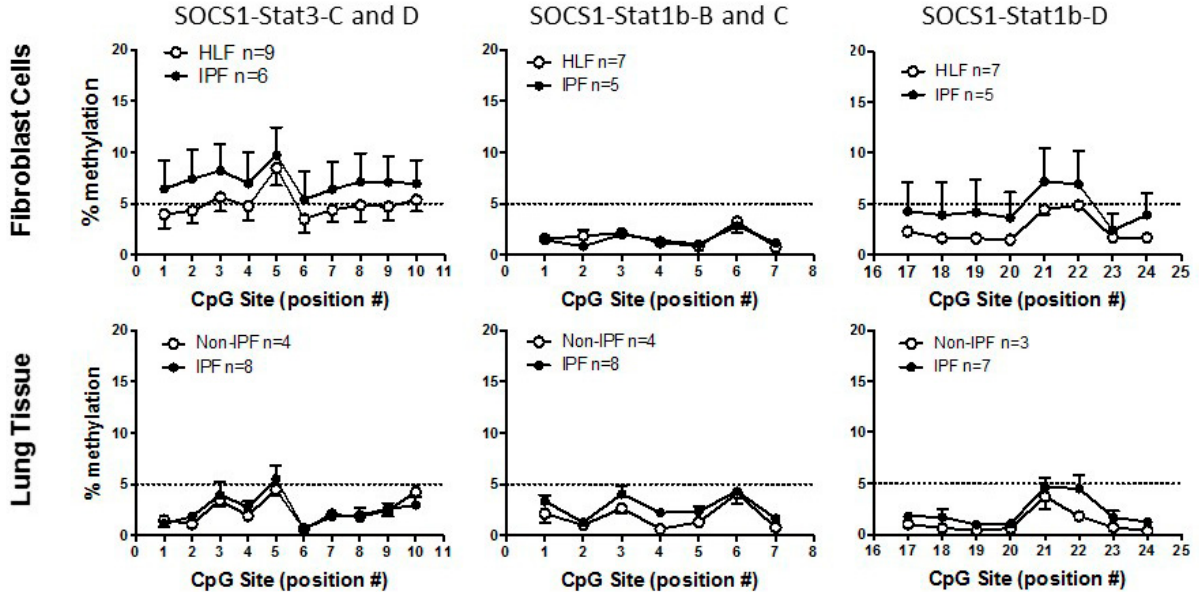
Figure 2. Approximately 500 bp of sequence surrounding the stat1 and stat3 transcription factor binding sites (TFBS) in the promoter region of SOCS1 were input into the software. CpG sites within or adjacent to the predicted TFBS were selected as target sites for analysis and primers designed to target these sites were chosen from a list generated by the software on the basis of the algorithms predicted assay quality. PCR sequencing primers for each assay are listed in Table 1. DNA samples were converted using the Epitect Bisulphite Conversion Kit (Qiagen). All PCR amplifications were performed with the PyroMark PCR Kit (Qiagen) and products visualized on a 2% agarose gel to confirm quality. The amplicons containing the CpG target sites were PCR amplified using a biotin labeled, HPLC purified forward primer and standard sequencing grade reverse primer. The PCR product was bound to streptavidin sepharose high performance beads (GE Healthcare Life Sciences), following a washing and denaturation step the beads were transferred to optically clear, 24 well sequencing plate in the presence of the pyrosequencing primer. Pyrosequencing was performed on a PyroMark 24 Pyrosequencing System (Qiagen) as per the manufacturer’s instructions. Data were analyzed on the PyroMark Q24 software to give the % methylation values for each CpG site in the sample. In this study, three assays were performed, SOCS1-Stat3-C and D; SOCS1-Stat3b-B and C and SOCS1-Stat1-D (Table 1). Analysis of control human lung fibroblasts (HLF) n ≥ 7 or IPF fibroblasts n ≥ 5 are graphed. Similar analysis was performed on DNA extracted from formalin-fixed paraffin-embedded lung tissue samples with non-IPF ( n ≥ 3) and IPF ( n ≥ 7). Methylation levels were low in all samples, with less than 5% methylation detected in all but SOCS1-Stat3C-D assay of HLF vs. IPF. These data suggest that methylation of putative STAT1 and STAT3 TFBS within the SOCS1 promoter are not altered in Table 1. Primer sequences for pyrosequencing assays. Assay name.